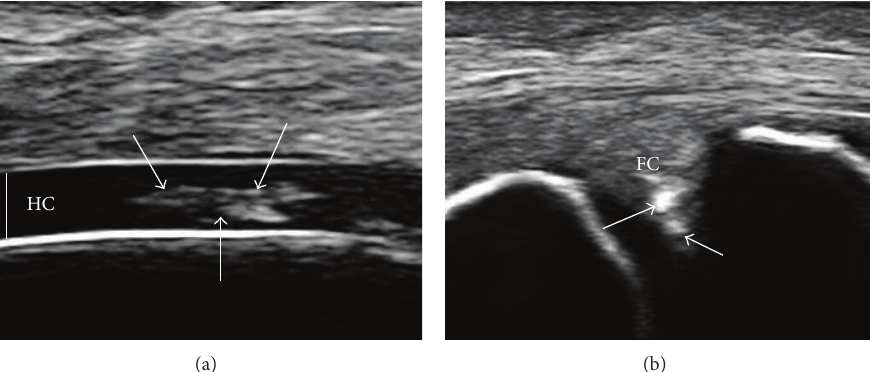
Figure 1: US aspect of CPPD deposits (arrows) in the hyaline cartilage (HC) of the femur in a knee joint and in the fibrocartilage (FC) of a medial